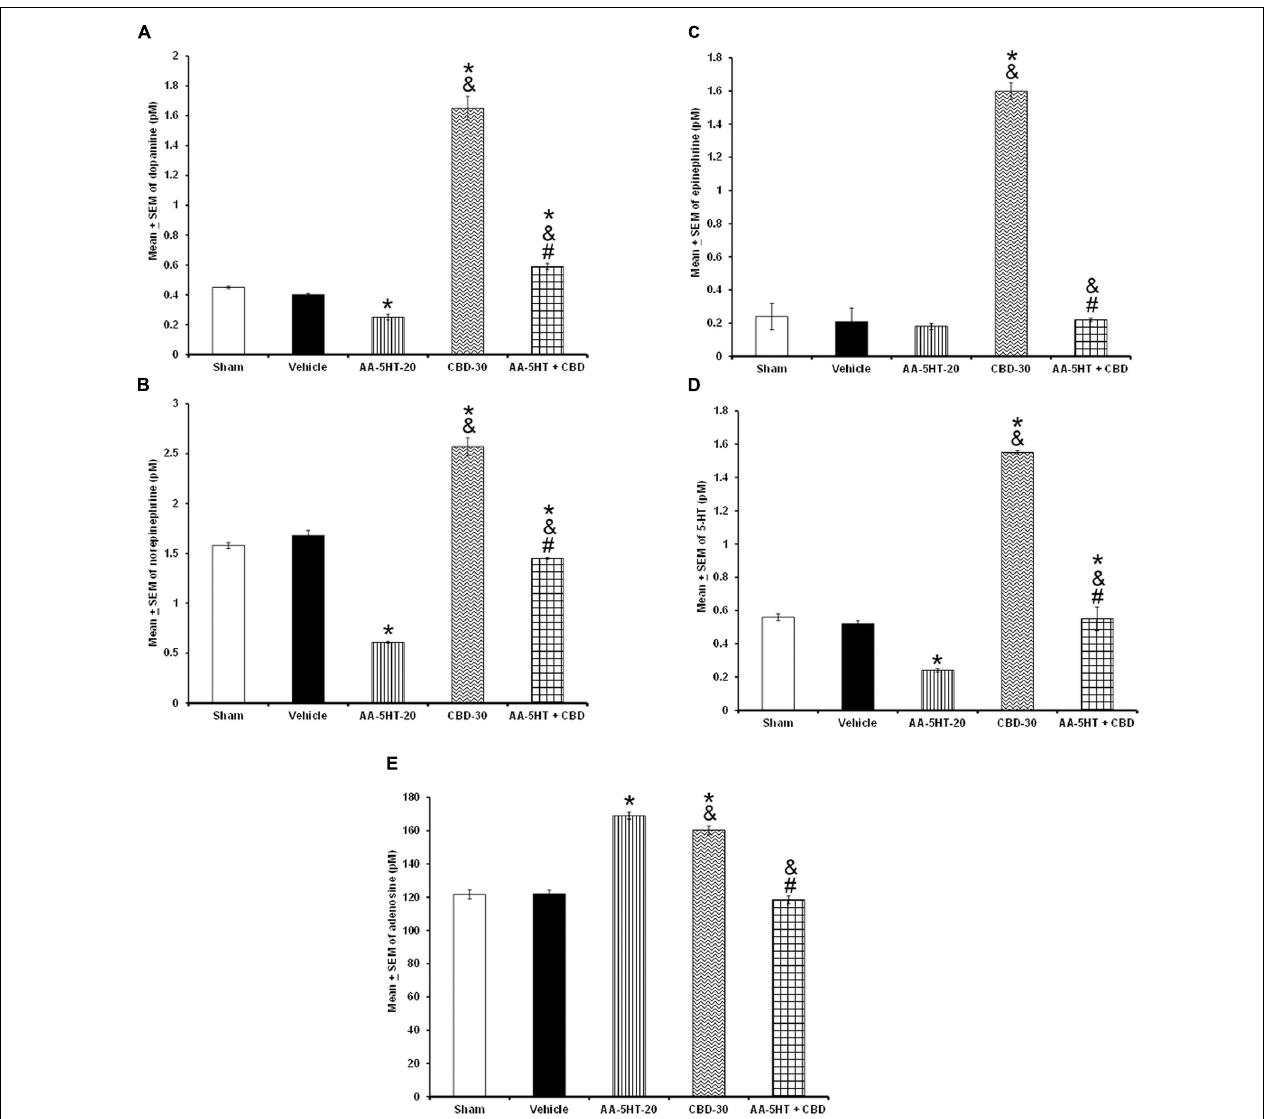
FIGURE 8 | Effects on the extracellular levels of DA, NE, EP, 5-HT, and AD after the administration of AA-5-HT (20 mg/Kg; i.p.), cannabidiol (CBD; 30 mg/Kg; i.p.) or AA-5-HT (20 mg/Kg; i.p.) and 15 min CBD (30 mg/Kg; i.p.) at the beginning of the lights-on period. Administration of AA-5-HT decreased extracellular contents of DA, NE, 5-HT and increased AD levels as well. No statistical differences were observed in NE contents. Moreover, injection of CBD (30 mg/Kg; i.p.) increased all neurotransmitters levels. Next, the administration of AA-5-HT before injection of CBD was able to prevent the enhancement in DA, NE, EP, 5-HT as well as AD levels ( A–E , respectively. Mean ± SE. ∗ vs. Sham/Vehicle, P < 0.05; & vs. AA-5-HT-20, P < 0.05; # vs. CBD-30, P < 0.05). Abbreviations: Cannabidiol 30 mg/Kg, i.p. (CBD-30), AA-5-HT-20 mg/Kg (AA-5-HT-20).